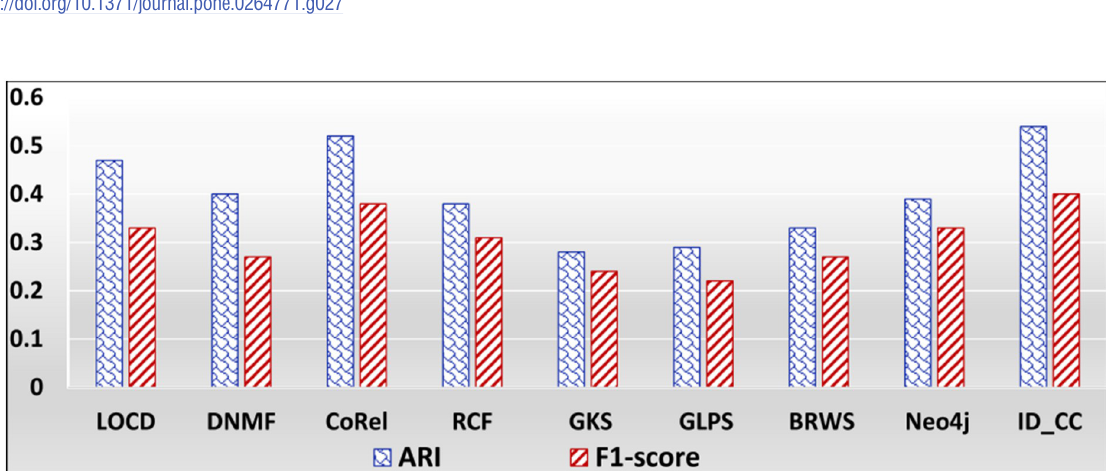
PLOS ONE | https://doi.org/10.1371/journal.pone.0264771 April 19,